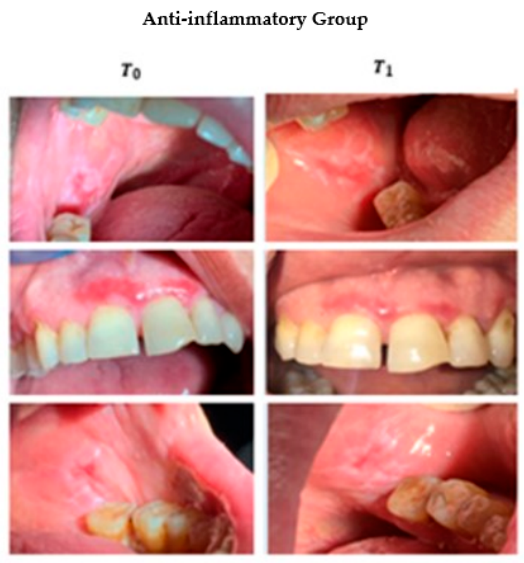
Figure 3. Intra-oral photos of some of the subjects who joined the clinical trial at T0 and T1. The action of the drug on the lesions can be seen after 12 weeks of treatment (Anti-inflammatory group). Table 3. Variation of the OLP symptoms score after the administration of the two protocols adopted. SD, standard deviation.